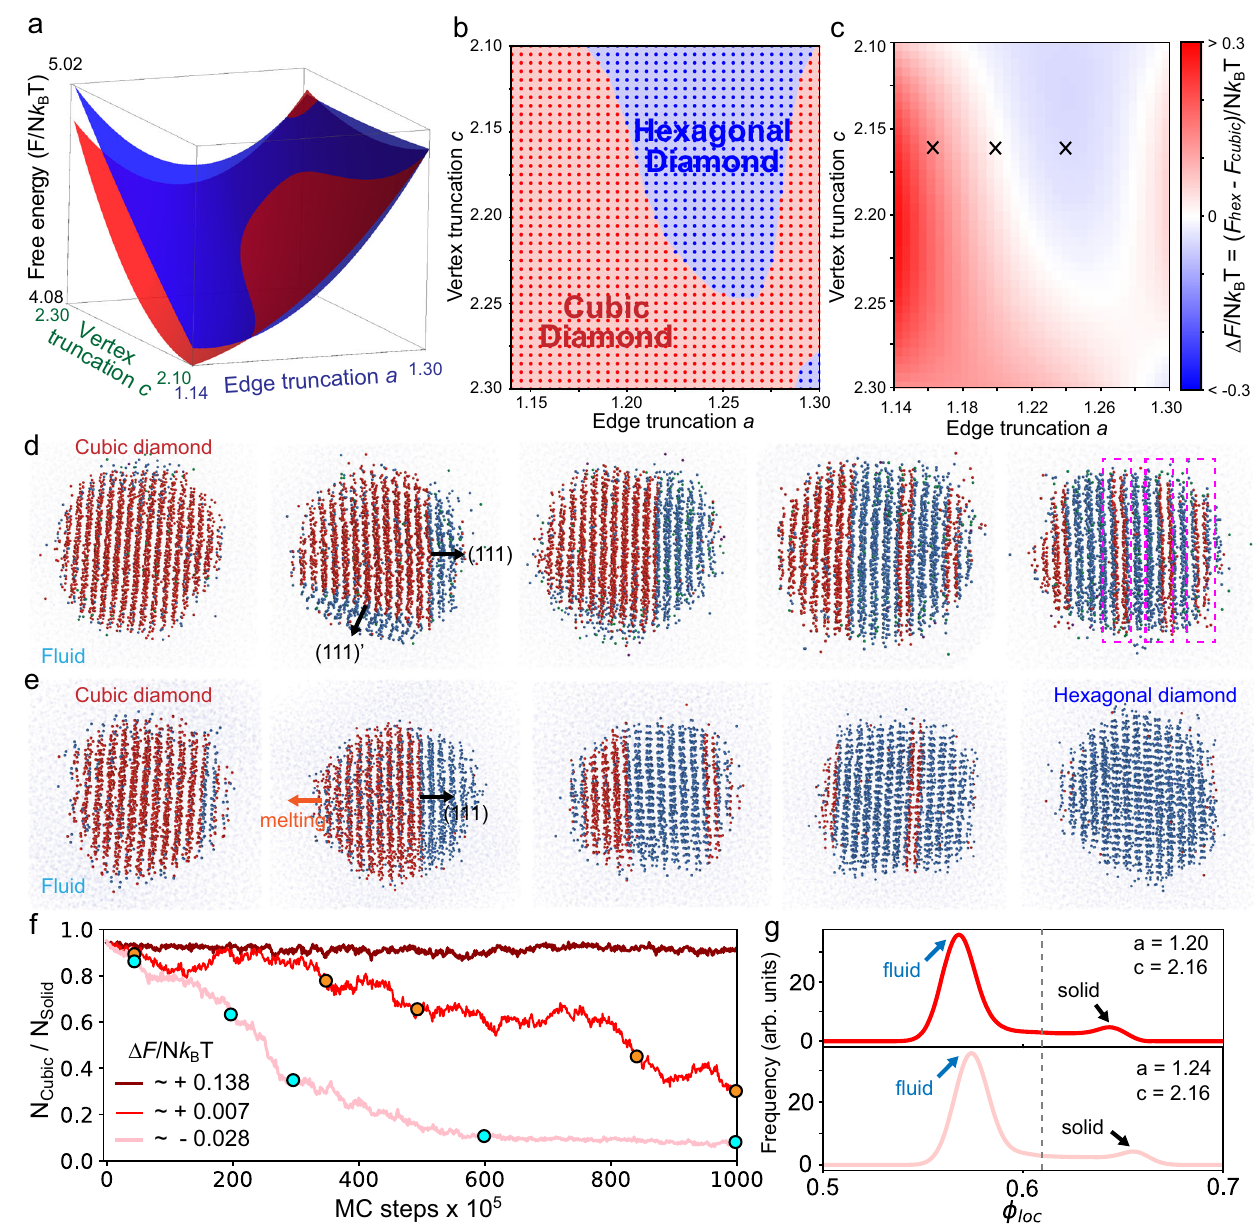
Fig. 2 | Stability control of diamond crystals via particle shape design. a Per- particle Helmholtz free-energy ( F = Nk B T ) plot, in units of k B T , of cubic (red) and hexagonal (blue) diamond crystals of hard TTs as a function of vertex and edge truncation parameters at constant particle volume fraction ( ϕ =0 : 62). b Phase diagram ofhard TTs in theshape spacedetermined by the free-energy calculation. c Free-energy difference between cubic and hexagonal diamond ( 4 F = F H (cid:3) F C ) in shape space. d , When the TT is designed ð a =1 : 20, c =2 : 16 Þ to have negligible 4 F ∼ +0 : 007, the initial cubic diamond (left) single-crystalline cluster forms mul- tiple stacking faults (right) in fl uid, suggesting that the free energy loss from the twinboundariesissmall.EachTTisrepresentedbyatinysphereattheTTcenterof